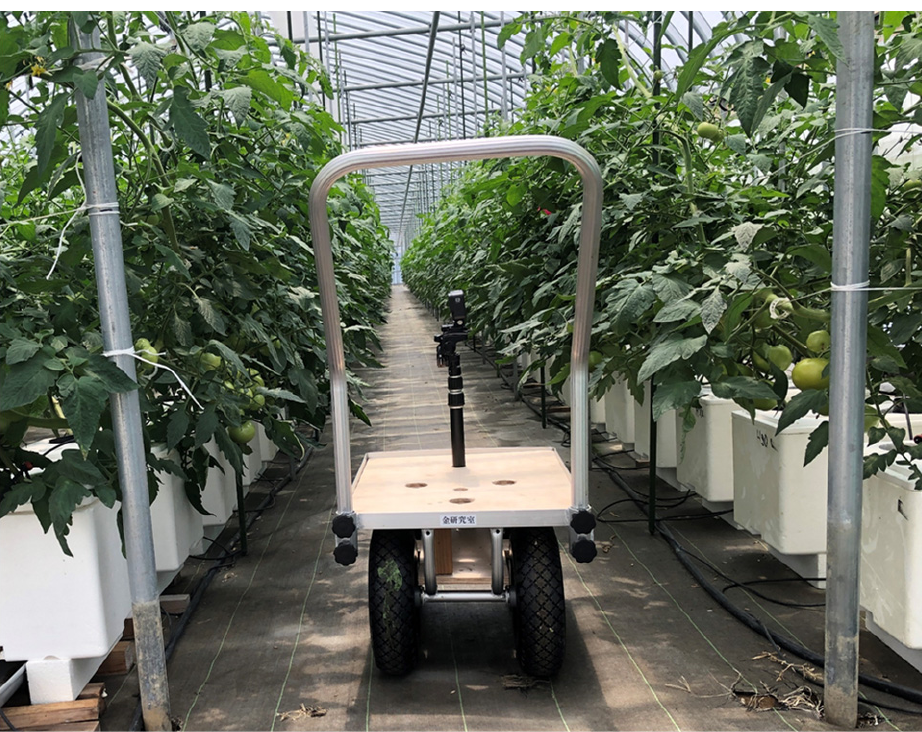
Figure 2. Taking images in the field.